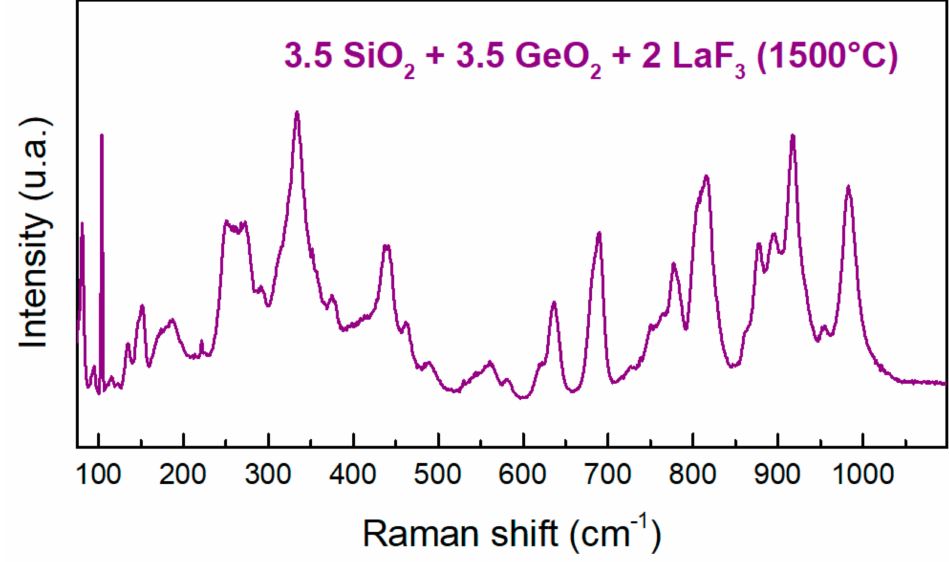
Figure 16. Raman spectrum of Si-Ge-La after thermal